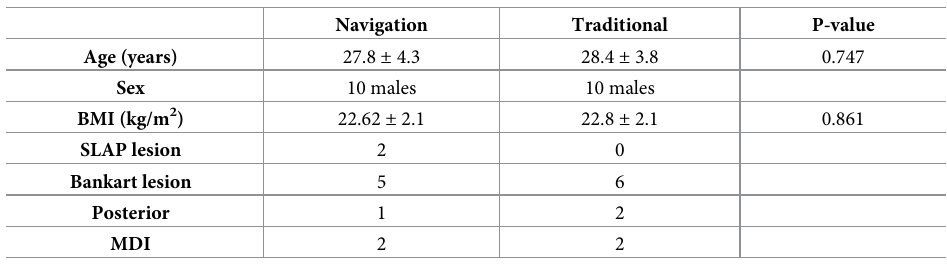
Table 1. Demography of patients.